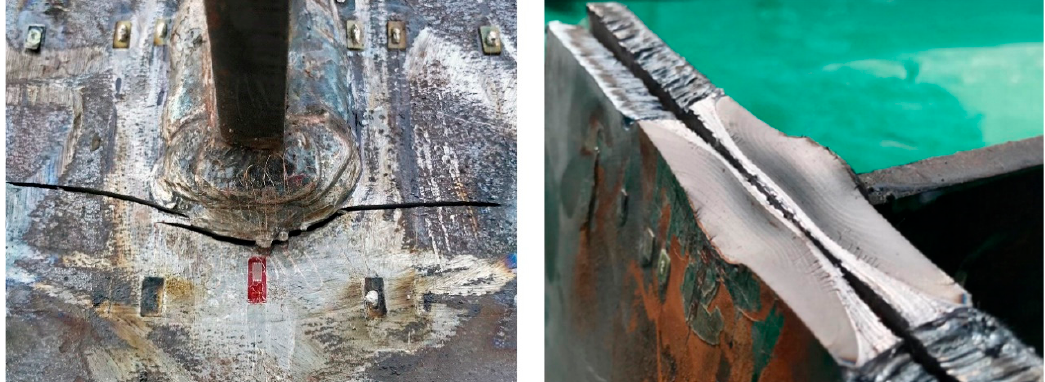
Figure 7. Failure mode.